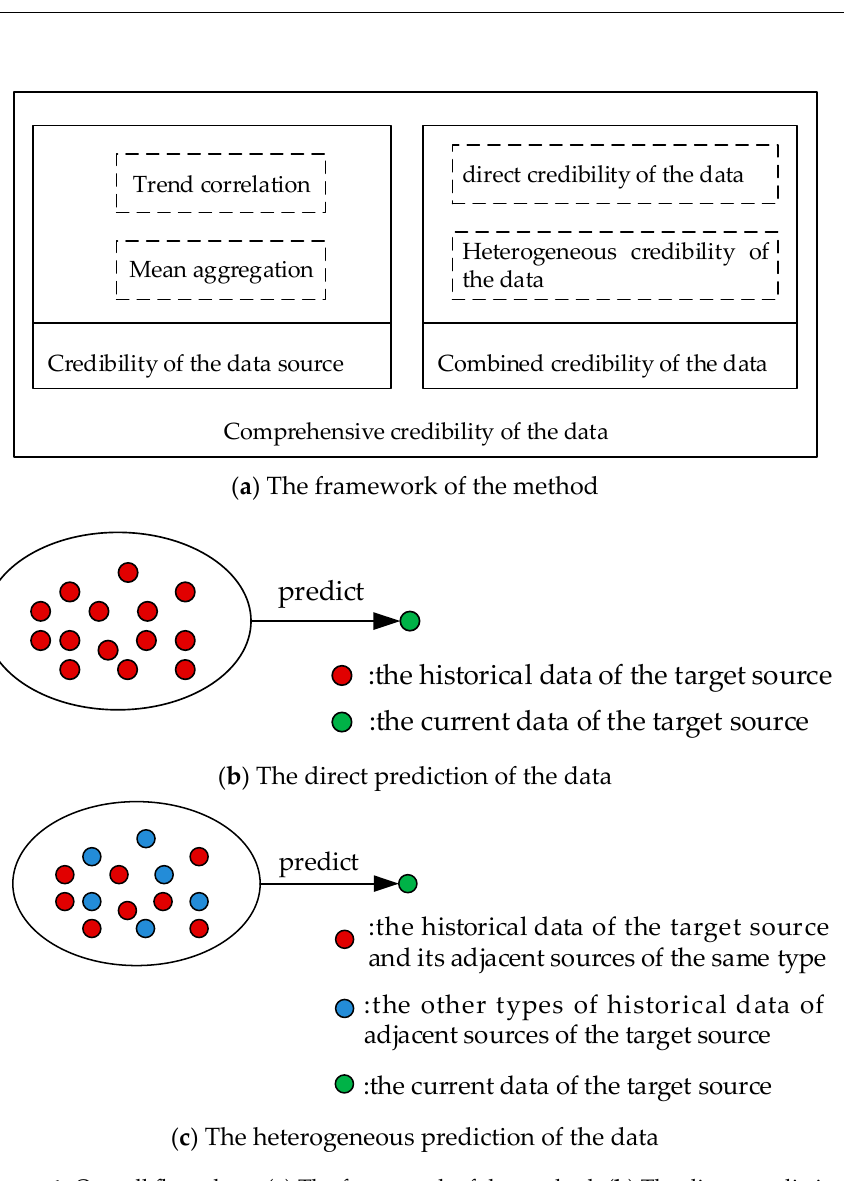
Figure 1. Overall flow chart. ( a ) The framework of the method. ( b ) The direct prediction of the data. ( c ) The heterogeneous prediction of the data.